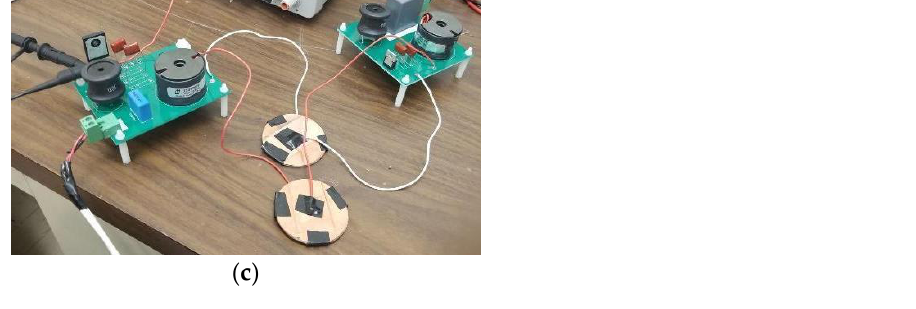
Figure 9. Hardware setup of the CPT system. ( a ) Class-E inverter. ( b ) Class-E rectifier. ( c ) Class-E 2 converter with capacitive coupling plates.